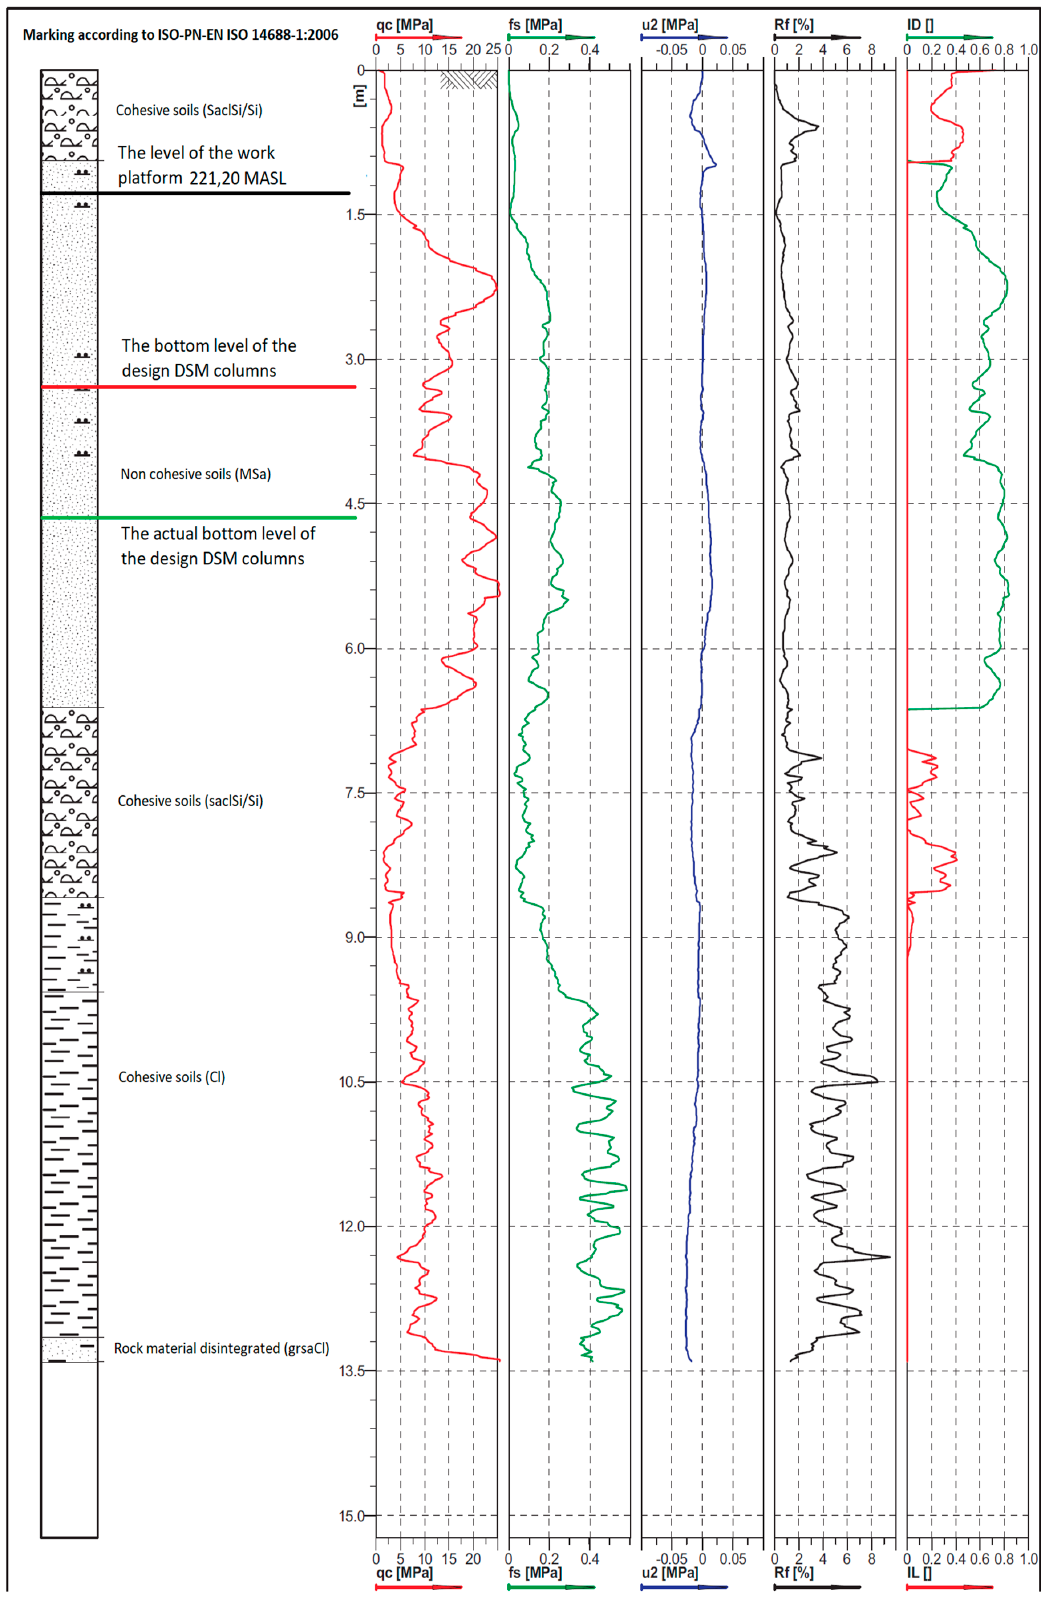
Figure 5. Results of the complementary CPTU survey—probe No. 10.